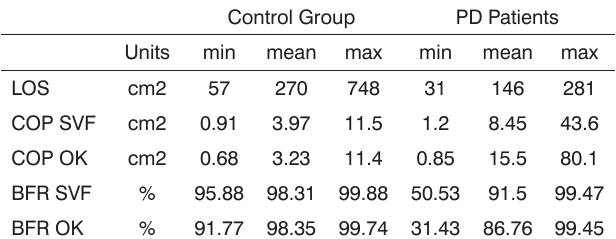
Mean, minimum and maximum values for all param- eters measured (LOS, COP) and calculated